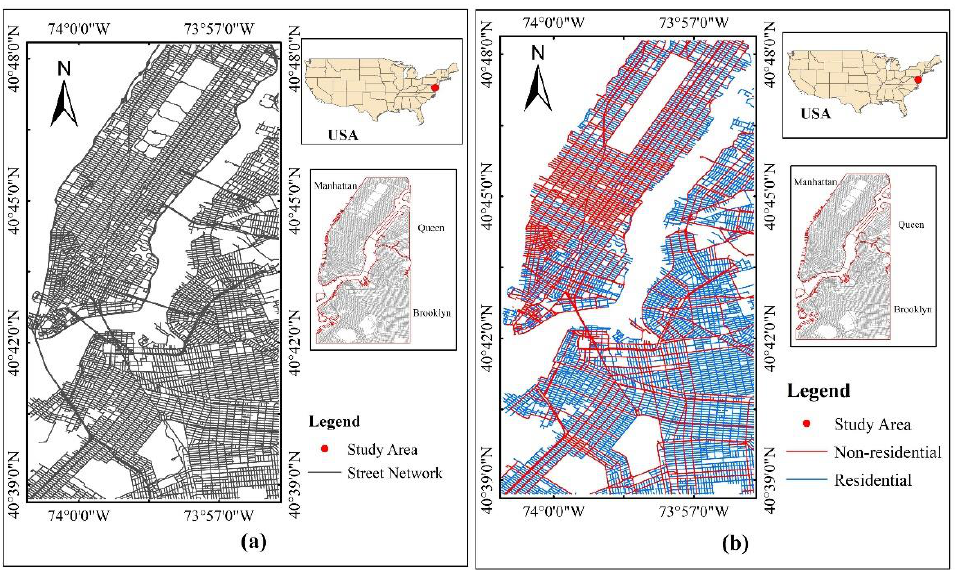
Figure 1. Street network of OpenStreetMap (OSM): ( a ) overall street network; ( b ) residential and nonresidential streets in study area.